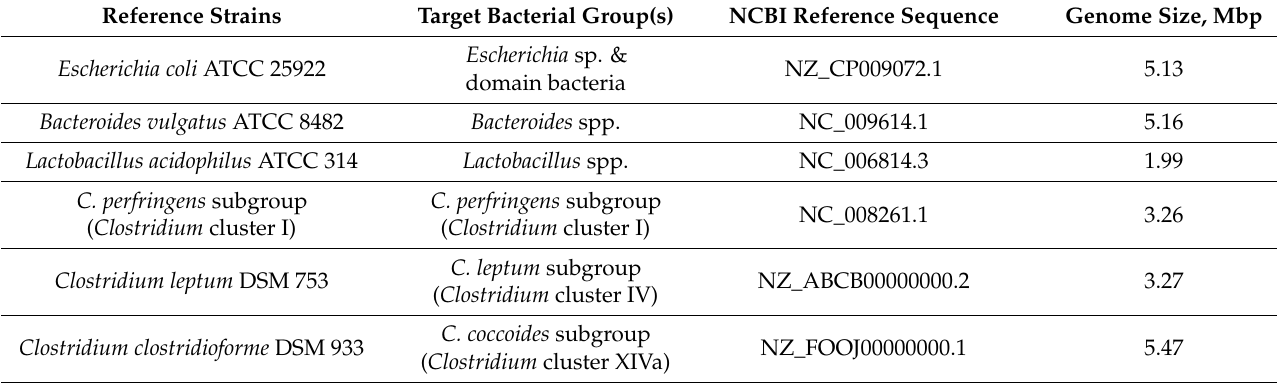
Table 3. Bacterial reference strains used for analytical process calibration